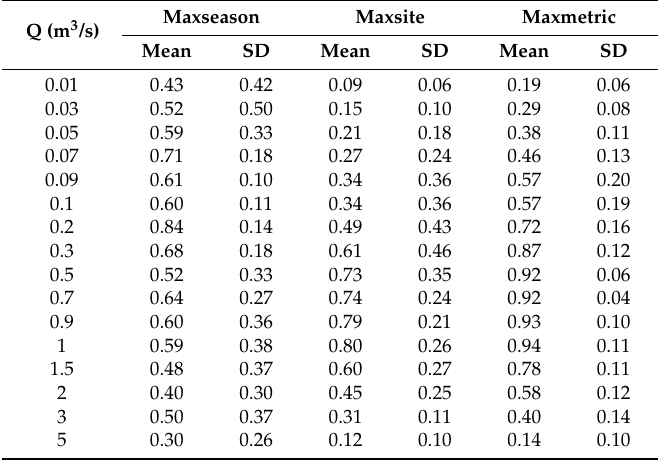
Table A4. Seasonal OFS means and standard deviations (SD) within the various κ -normalization alternatives for the Oinoi reach. The OFS values of spring, summer and autumn for each discharge (Q) have been averaged.